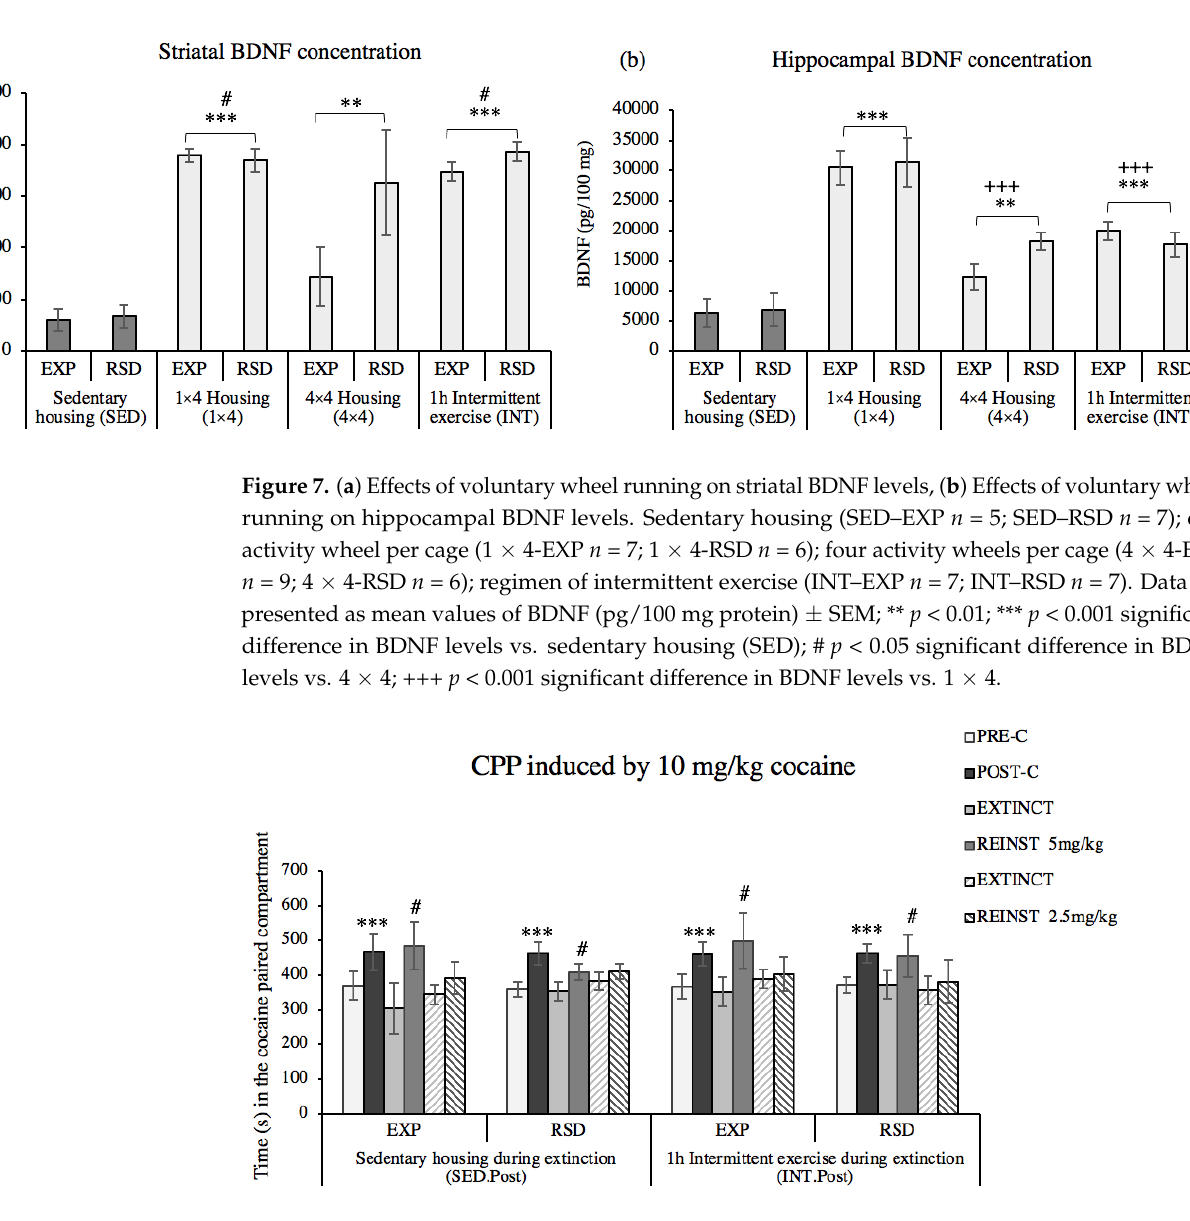
Figure 9. An increase of physical exercise during the extinction of drug-associated memories modi- fies the number of sessions needed to extinguish CPP induced by 10 mg/kg of cocaine. Black bars represent the mean of sessions required to extinguish the preference induced by 10 mg/kg cocaine,